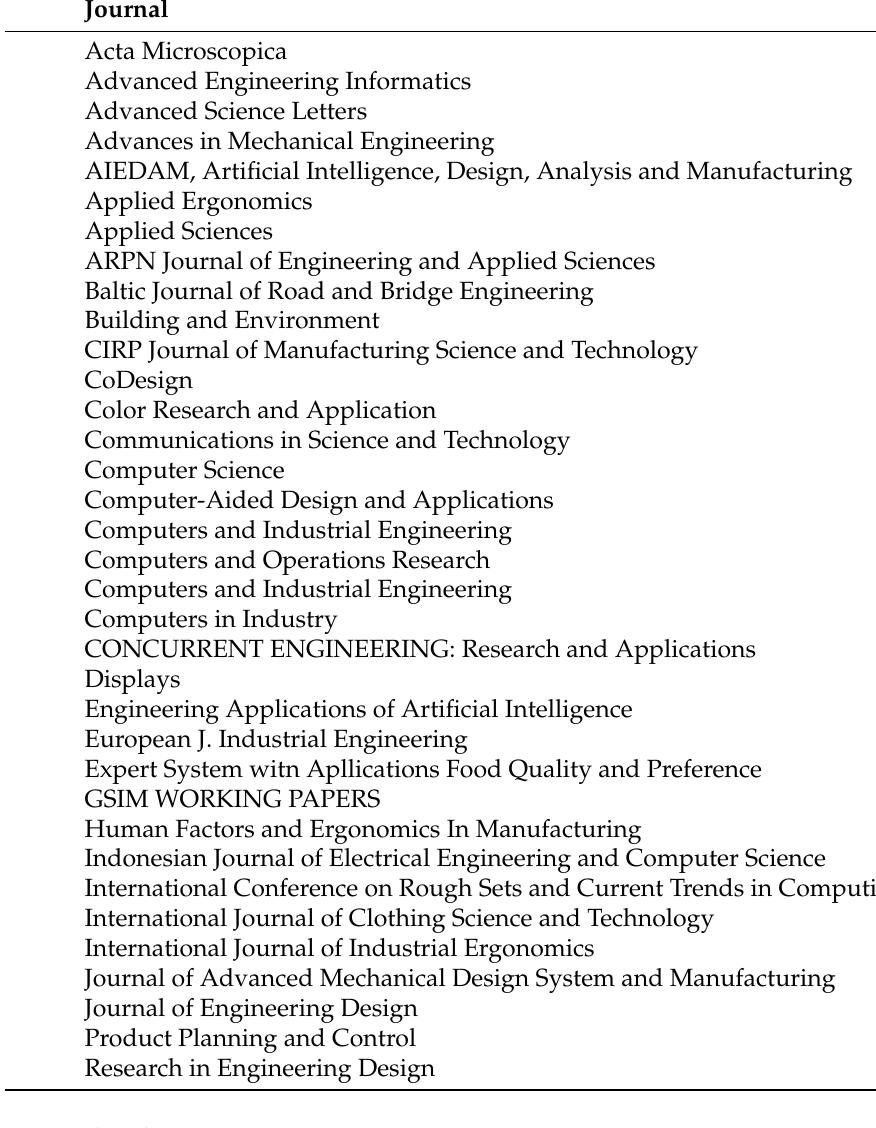
Table 1. Selected journals and